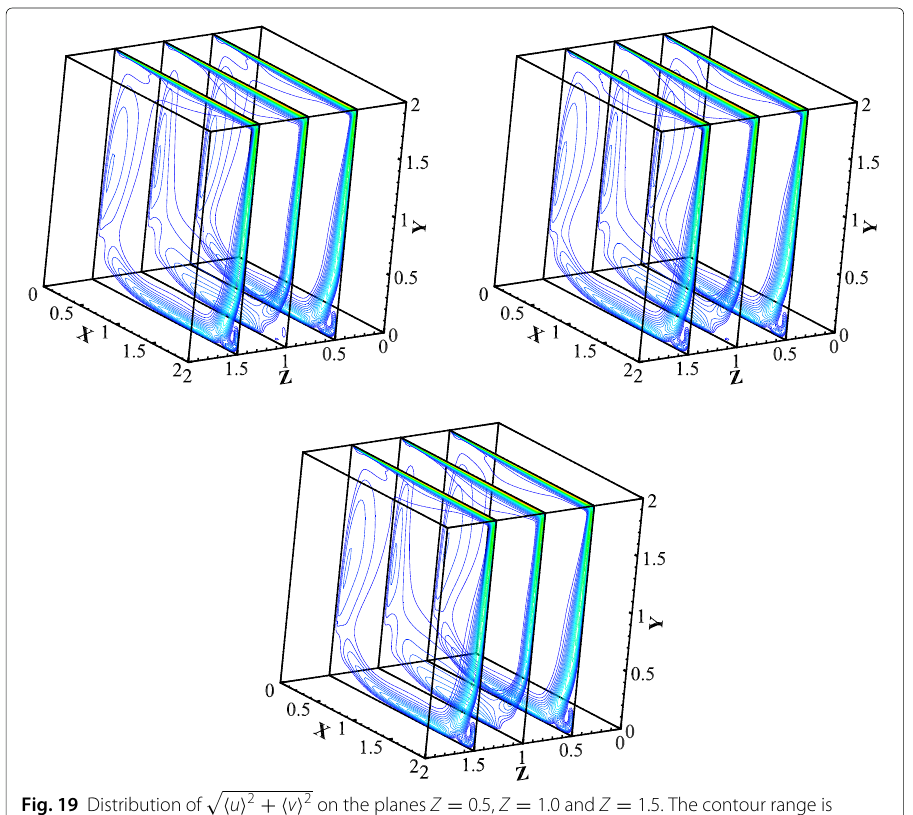
" (cid:12) u (cid:13) 2 + (cid:12) v (cid:13) 2 on the planes Z = 0.5, Z = 1.0 and Z = 1.5. The contour range is Fig. 19 Distribution of 0.01 − 0.13 with 50 levels. a No SGS model, b Vreman model, c WALE